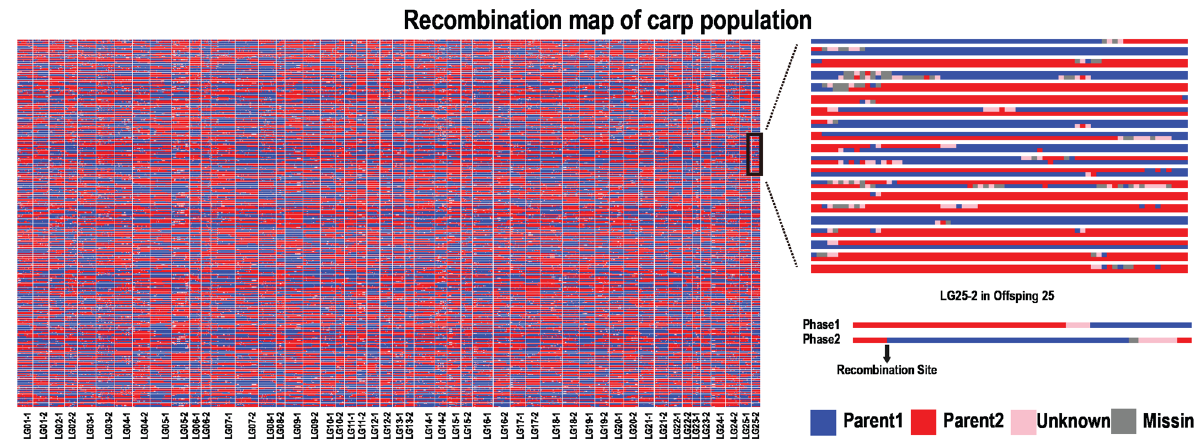
Figure 4. Genetic map validation by recombination mapping. Each two rows represent a genome in a CP population including 211 progenies and 2 parents. Columns correspond to chromosomes. Red and blue shading indicate maternal or paternal haplotype, respectively. Pink shading indicates ambiguous haplotypes, and grey shading indicates missing data. Only 1.51% of the markers were found in small recombination blocks.